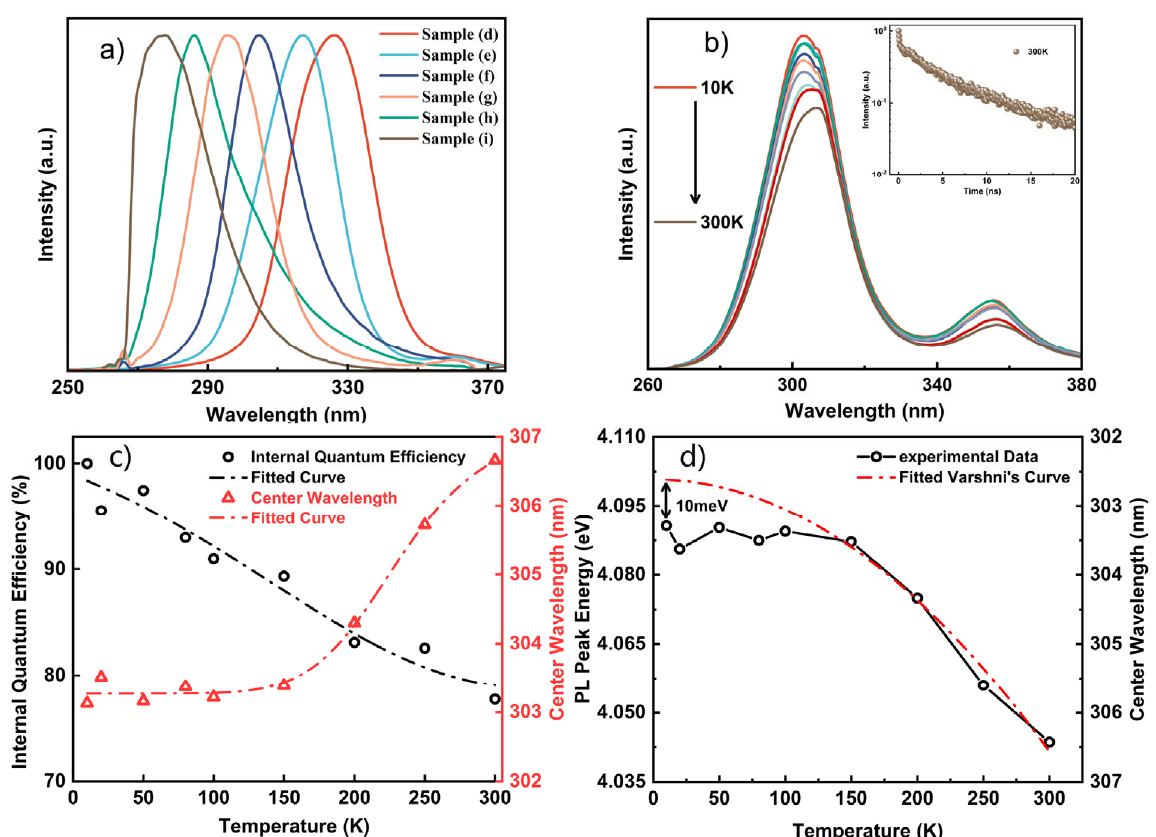
Figure 4. ( a ) PL spectra of the AlGaN nanowires with different emission wavelengths, ( b ) TDPL spectra of the AlGaN nanowires emission at 305 nm, ( c ) IQE and wavelength change curves with temperature change, ( d ) the wavelength shifts fitting curve using the Varshni empirical formula.